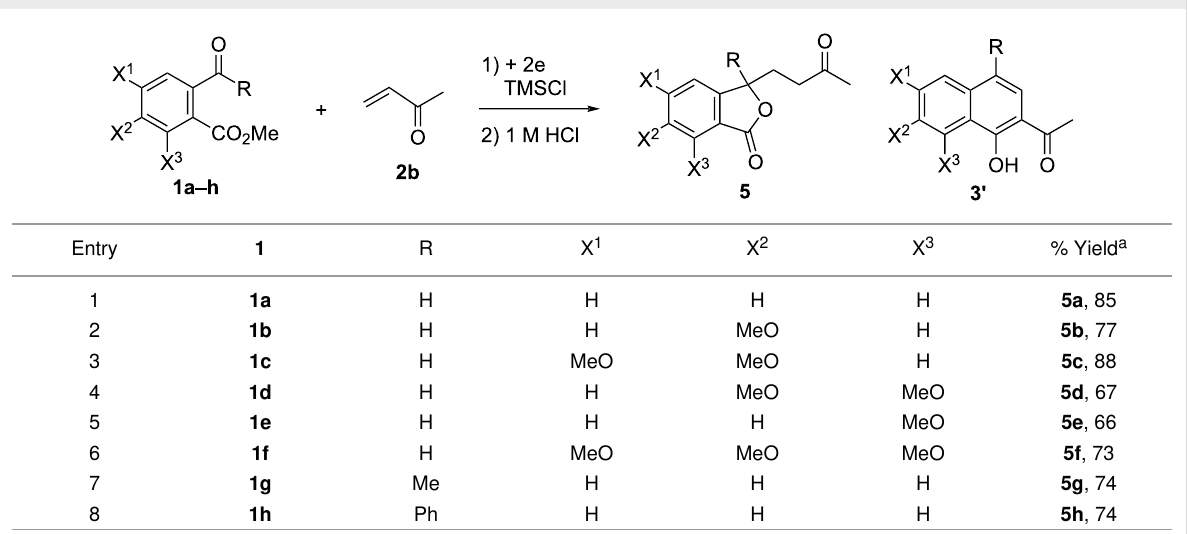
Table 2: Electroreductive coupling of 1a – h with methyl vinyl ketone ( 2b ) and subsequent treatment with 1 M HCl.